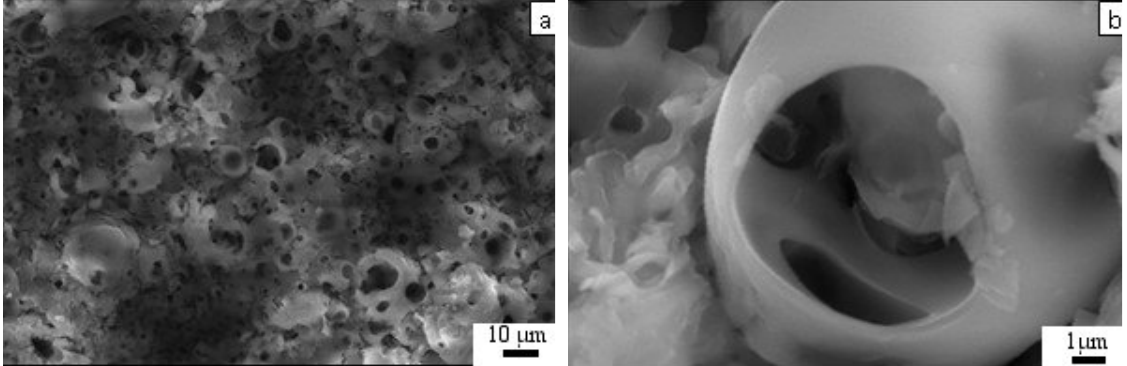
Figure 5. SEM images of the CP coating.